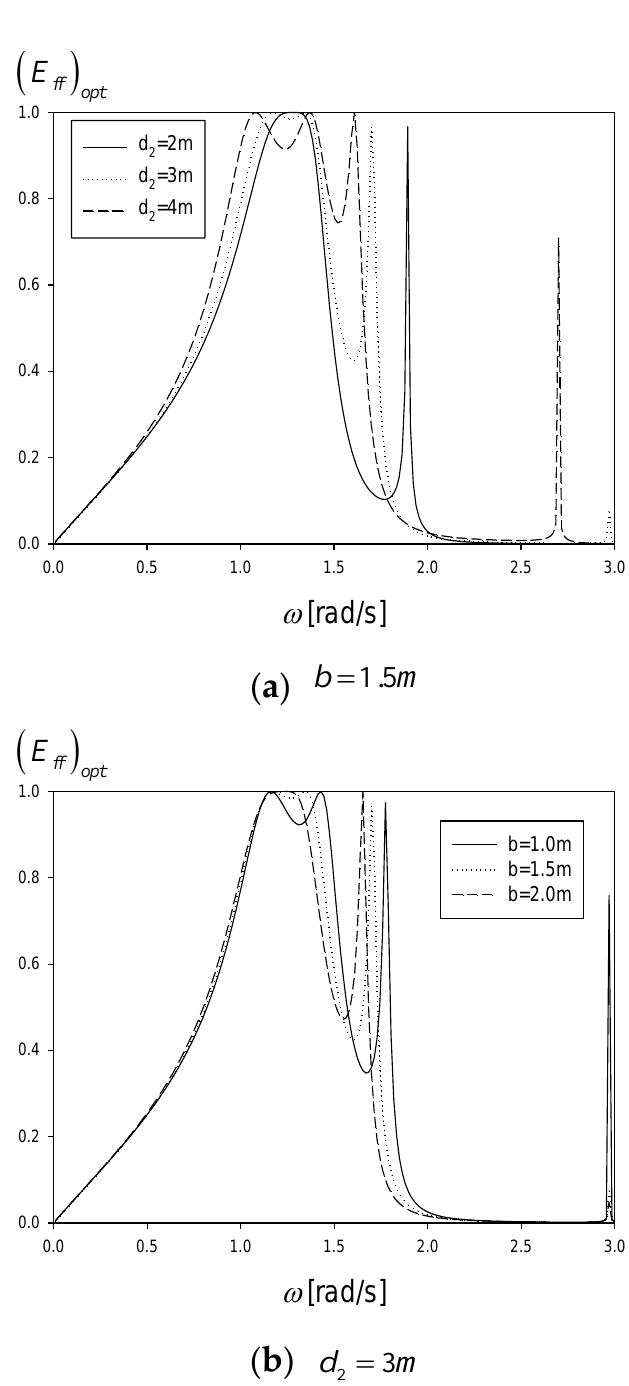
Figure 7. Conversion efficiency of a U-OWC device at the optimal turbine constant as a function of the submergence depth of the chamber wall ( a ) and barrier distance ( b ) for h = 10 m, a = 3 m, d 1 = 4 m. The non-dimensional significant wave force on the barrier is shown in Figure 8b as a function of the barrier height and energy period. The higher the barrier height, the larger the wave forces on the barrier especially at longer waves. Considering the above results, we have to design the optimal barrier height with a strategy that gives the higher conversion efficiency and lower wave